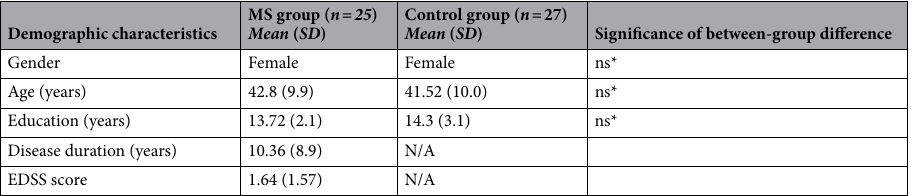
Table 1. Demographic and clinical characteristics of RRMS patients and control group. MS multiple sclerosis, RRMS relapsing–remitting MS, EDSS Expanded Disability Status Scale, SD standard deviation, N/A not applicable. *No significant between-group difference (p >